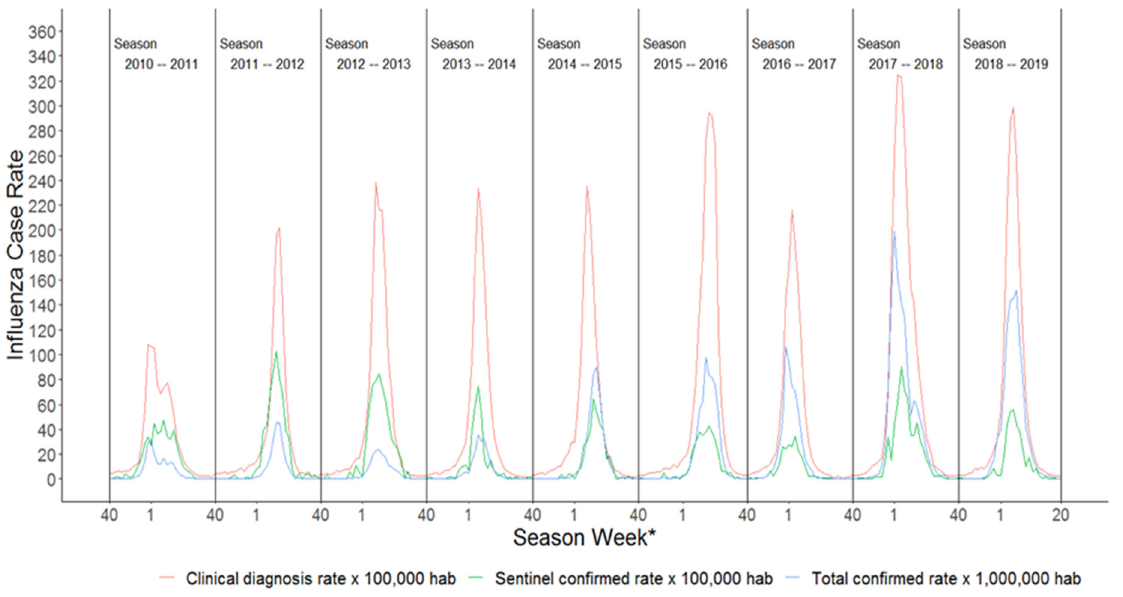
Figure 1. Clinical diagnostic rates, sentinel-confirmed rates, and total case rates. * Each season is represented from week 40 of the 1st year to week 20 of the 2nd year.